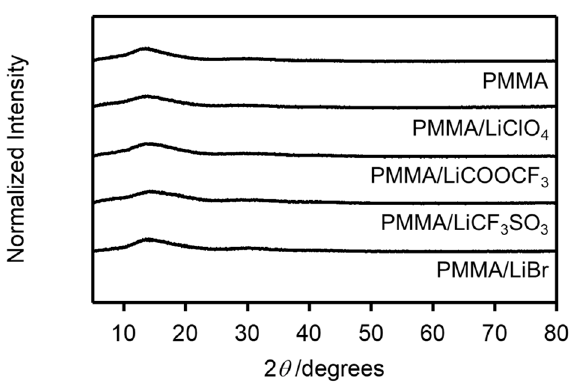
Figure 8. XRD patterns of PMMA/salt samples with [Li]/[C=O] = 0.07. Ultraviolet-visible (UV-vis) absorption spectra were obtained using V650 (JASCO Co., Ltd., Tokyo, Japan) for wavelengths in the 400–700 nm range. The UV-vis spectra of